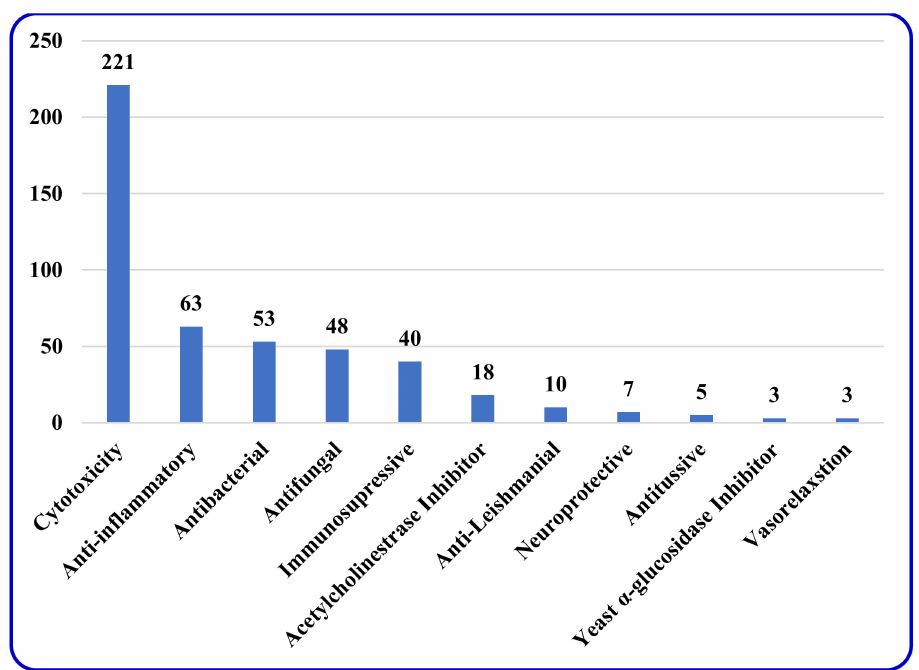
Figure 37. Number of compounds versus biological